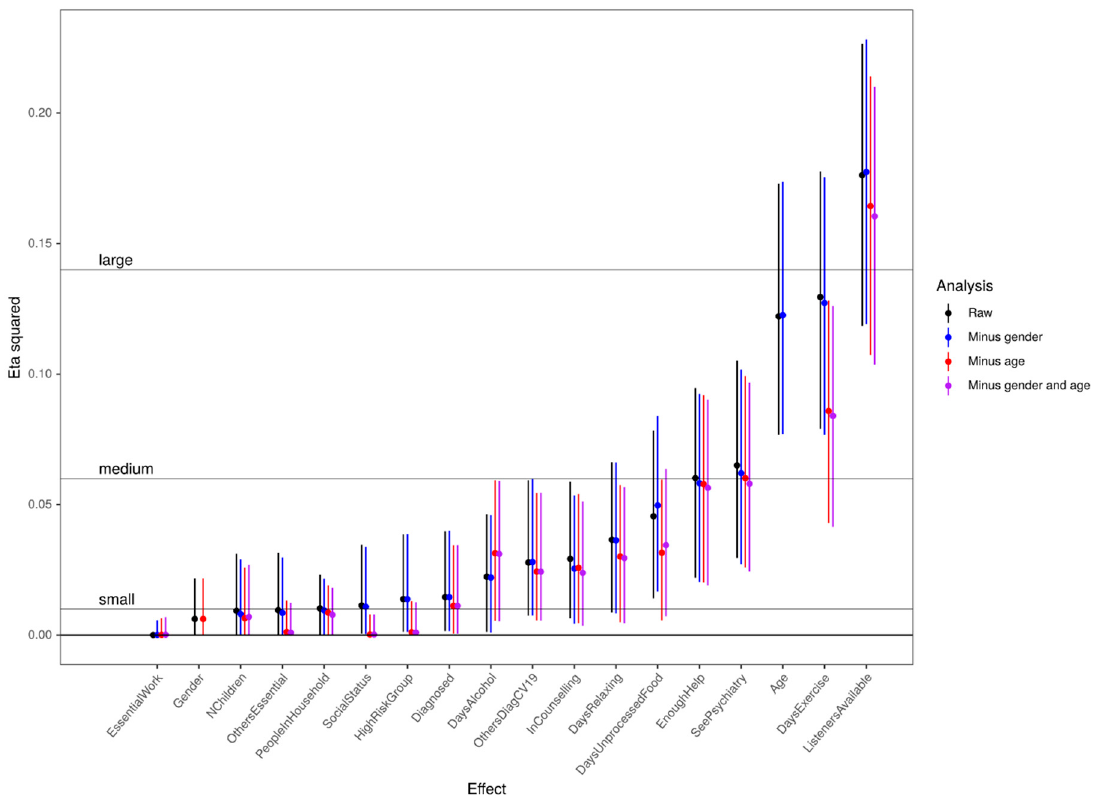
Figure 4. Effects sizes of relationships between predictors and CORE-OM NR score. Note . Forest plot of effect size, on the y axis, for relationship of predictor variables, on the x axis, and CORE-OM NR score. Effect sizes are eta squared values with parametric 95% CIs as vertical error bars around the observed values. For predictors other than gender and age, simple effects with no other predictors are shown (“Raw”) and then the simple effects after partialling out effects of gender, age and of both gender and age are shown. The raw effect of gender is show with the effect after partialling out the effect of age, and vice versa.